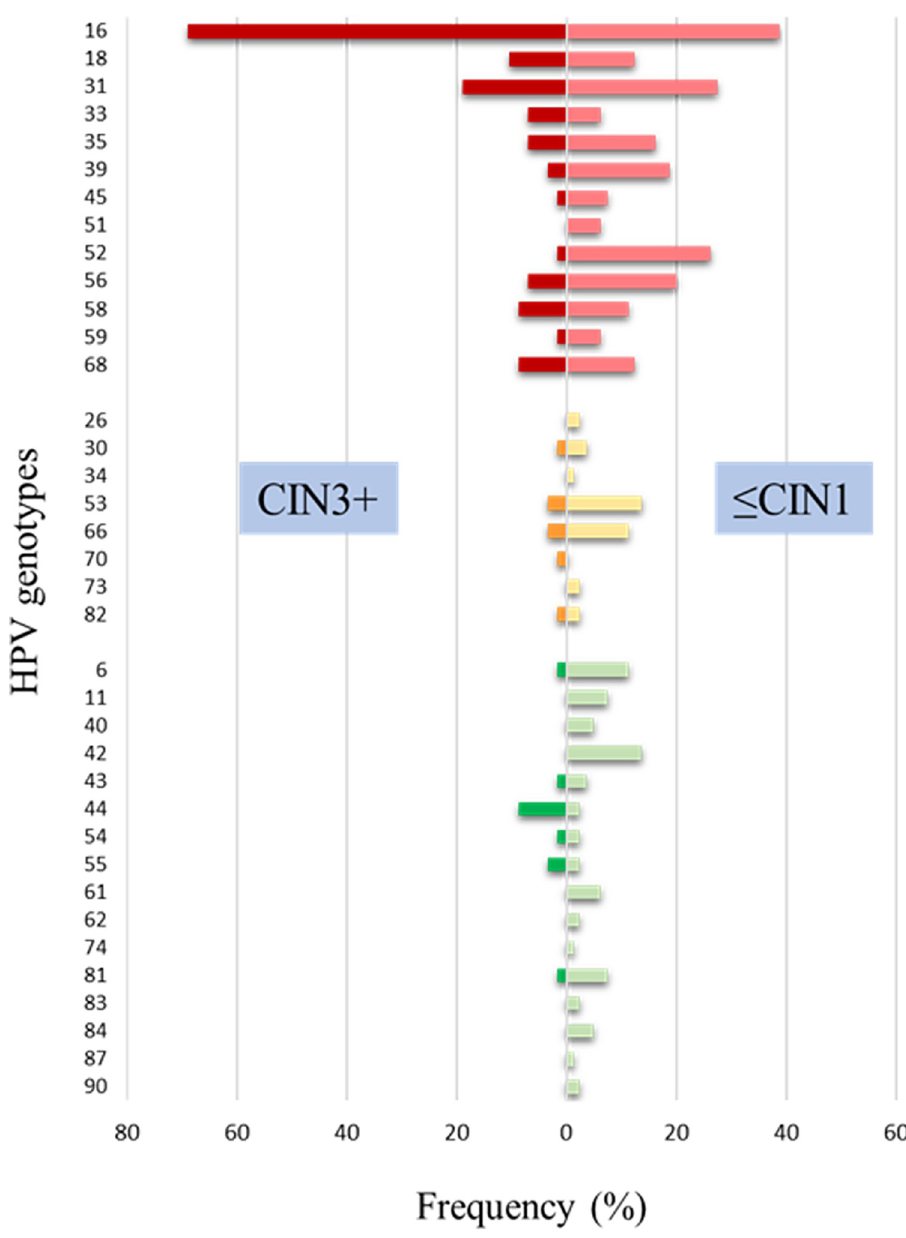
Fig 3. Distribution of HPV genotypes by severity of the lesion. HR-HPVs (Group 1 IARC) are in red, possible or probable HR-HPVs (Group 2A/2B IARC) are in orange and low-risk HPVs (Group 4 IARC) are in green. The analysis of the relative proportion of the genotypes identified in each sample is detailed in the heatmap (Fig 4A). According to the severity of the lesion different patterns were observed: in � CIN1, a wide diversity of HPV genotypes, both LR and HR, was observed in dif- ferent relative proportions in each sample, without a marked predominance of any of them; while the CIN3+ group exhibits a sharp drop in the diversity of genotypes with a notable pre- dominance of HR-HPVs, especially HPV 16. Notably, mean Gini index was significantly higher in < CIN1 samples, showing a 2.2-fold increase in genotypic diversity when compared